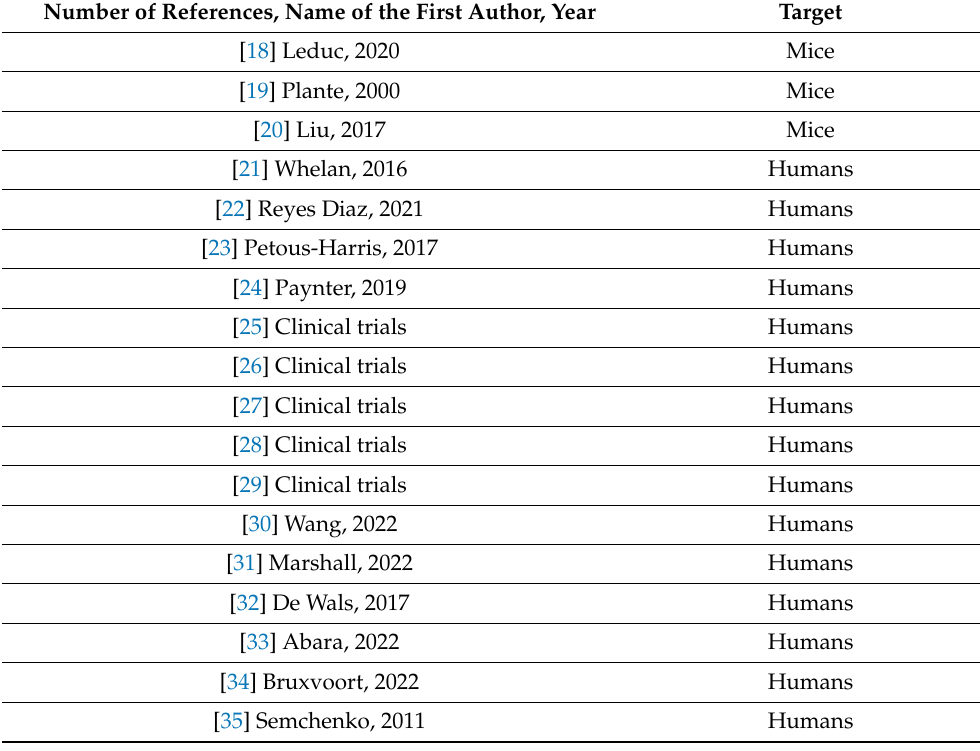
Table 2. Synthesis of the included